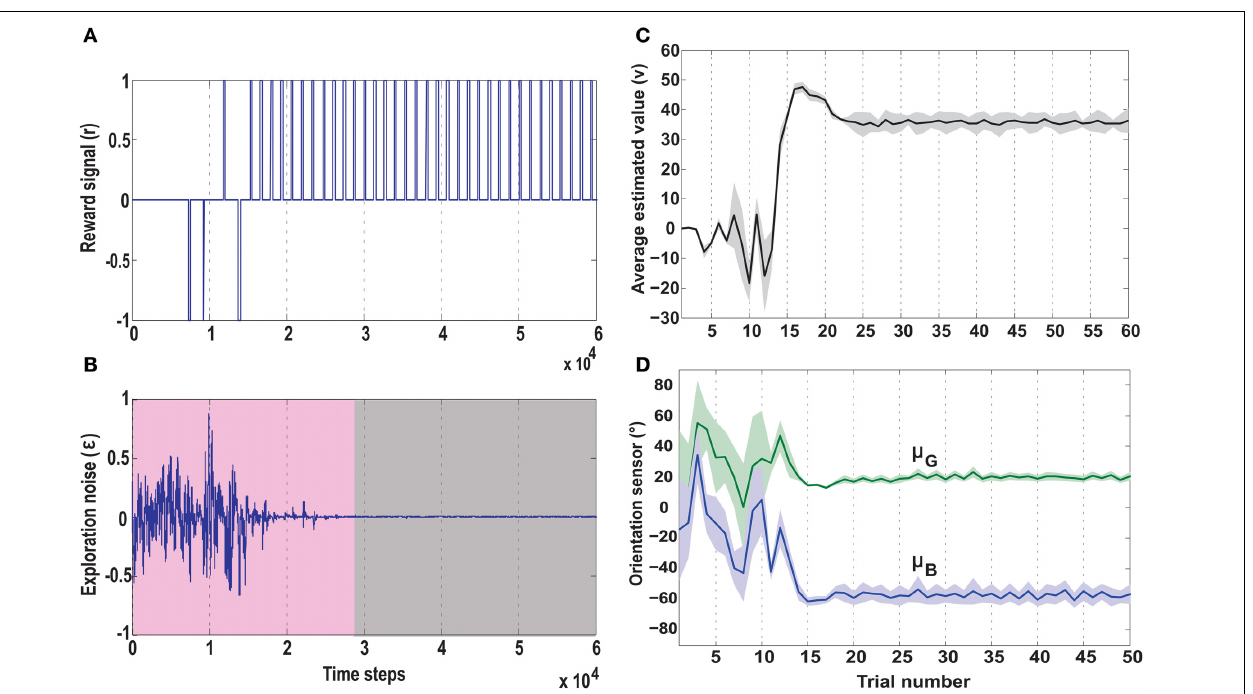
FIGURE 9 | Temporal development of key parameters of the actor-critic RL network, in the no obstacle foraging task. (A) Development of the reward signal (r) over time. Initially the robot receives a mix of positive and negative rewards due to random explorations. Upon successfully learning the task, the robot is steered toward the green goal every time, receiving only positive rewards. (B) Development of the exploration noise ( (cid:12) ) for the actor. During learning there is a high noise in the system (pink shaded region), which causes the the synaptic weights of the actor to change continuously. Once the robot starts reaching the green goal more often the TD error from the critic decreases leading to a decrease in exploration noise (gray shaded region), which in turn causes the weights to stabilize ( Figure 7 ). (C) Average estimated value (v) as predicted by the reservoir critic is plotted for each trial. The maximum estimated value is reached after about 18 trials after which the